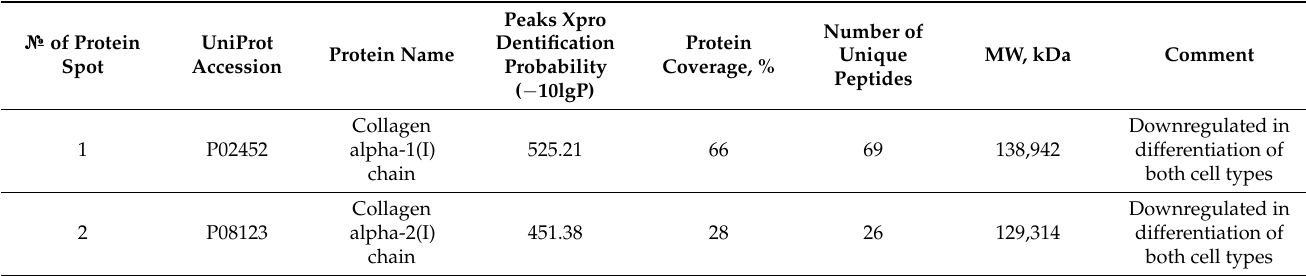
Figure 6. Differentially expressed proteins identified by 2D–DIGE. ( a ) Electropherogram corresponding to the overlapping of Cy fluorochrome channels of control (green) and differentiated (red) DPSC. Numbers marked differentially expressed protein spots reproducibly presented in both biological replicates of some of the biological groups. ( b ) Electropherogram corresponding to the overlapping of Cy fluorochrome channels of control (green) and differentiated (red) PDLSC. White circle—protein spots 5–7, specific for differentiated PDLSC. ( c ) Electropherogram corresponding to the overlapping of Cy fluorochrome channels of differentiated DPSC (green) and differentiated (blue) PDLSC. White circle—protein spots 5–7, specific for differentiated PDLSC. Table 3. Results of MS/MS identification of protein spots from Figure 6. The best scores from at least two technical replicates are